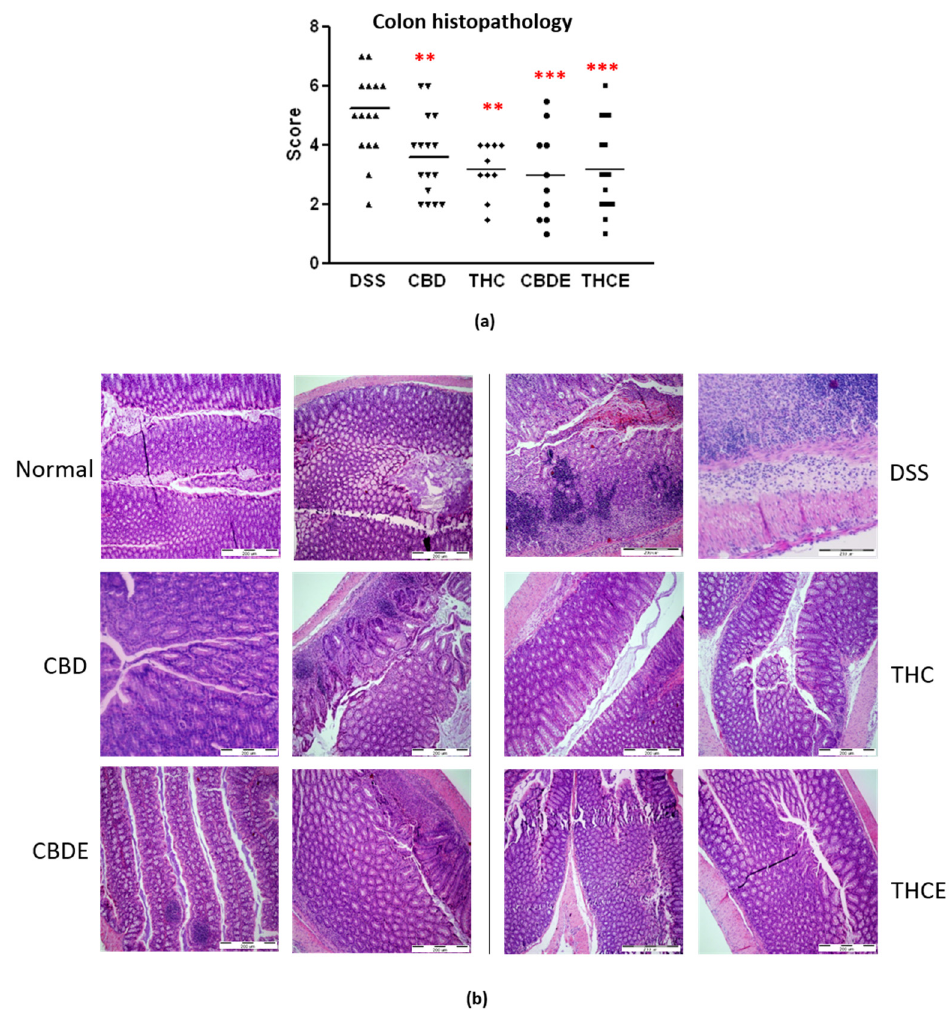
Figure 5. Histopathology of the colons of DSS model mice. Paraffin sections were stained with H&E and scored for inflammation and tissue damage; ( a ) Summary of average scores. p -value as compare with the DSS control group **, <0.01; ***, <0.001; ( b ) representative pictures of H&E stained sections.